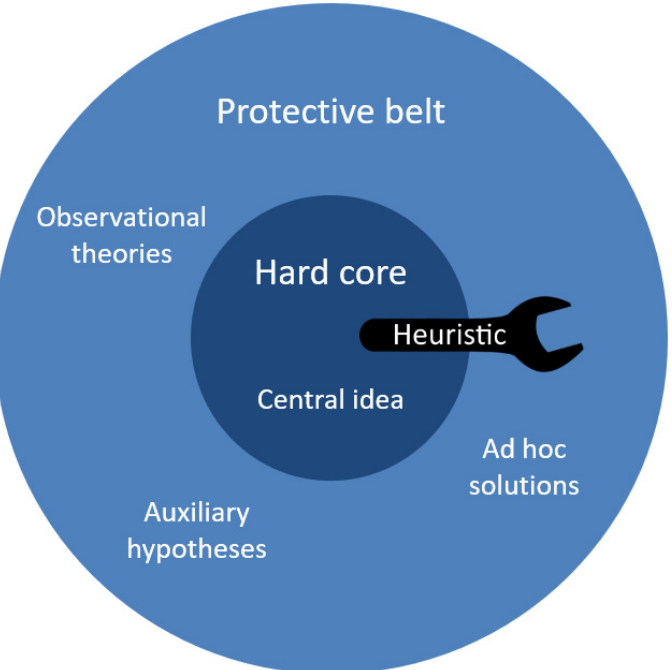
Figure 1. A research programme consists of a hard core of static beliefs, a heuristic, and a protective belt containing all other knowledge. The protective belt is dynamic and adapts in such a way that observations can be explained without affecting the hard core.